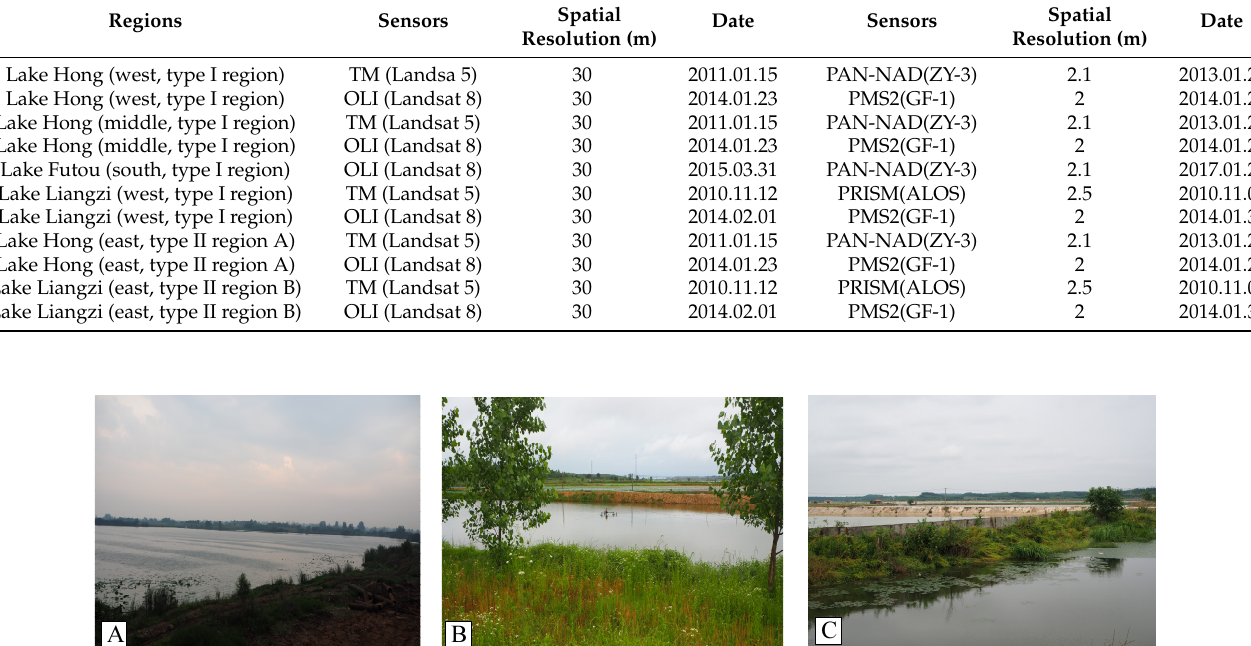
Figure 2. Field photos of inland aquaculture ponds in Hubei Province, China. Aquaculture ponds are usually equipped with air pumps. ( A ) A branch of a natural lake. ( B ) An aquaculture pond equipped with oxygen pumps. ( C ) Below is a small river (natural water body) and above are several aquaculture